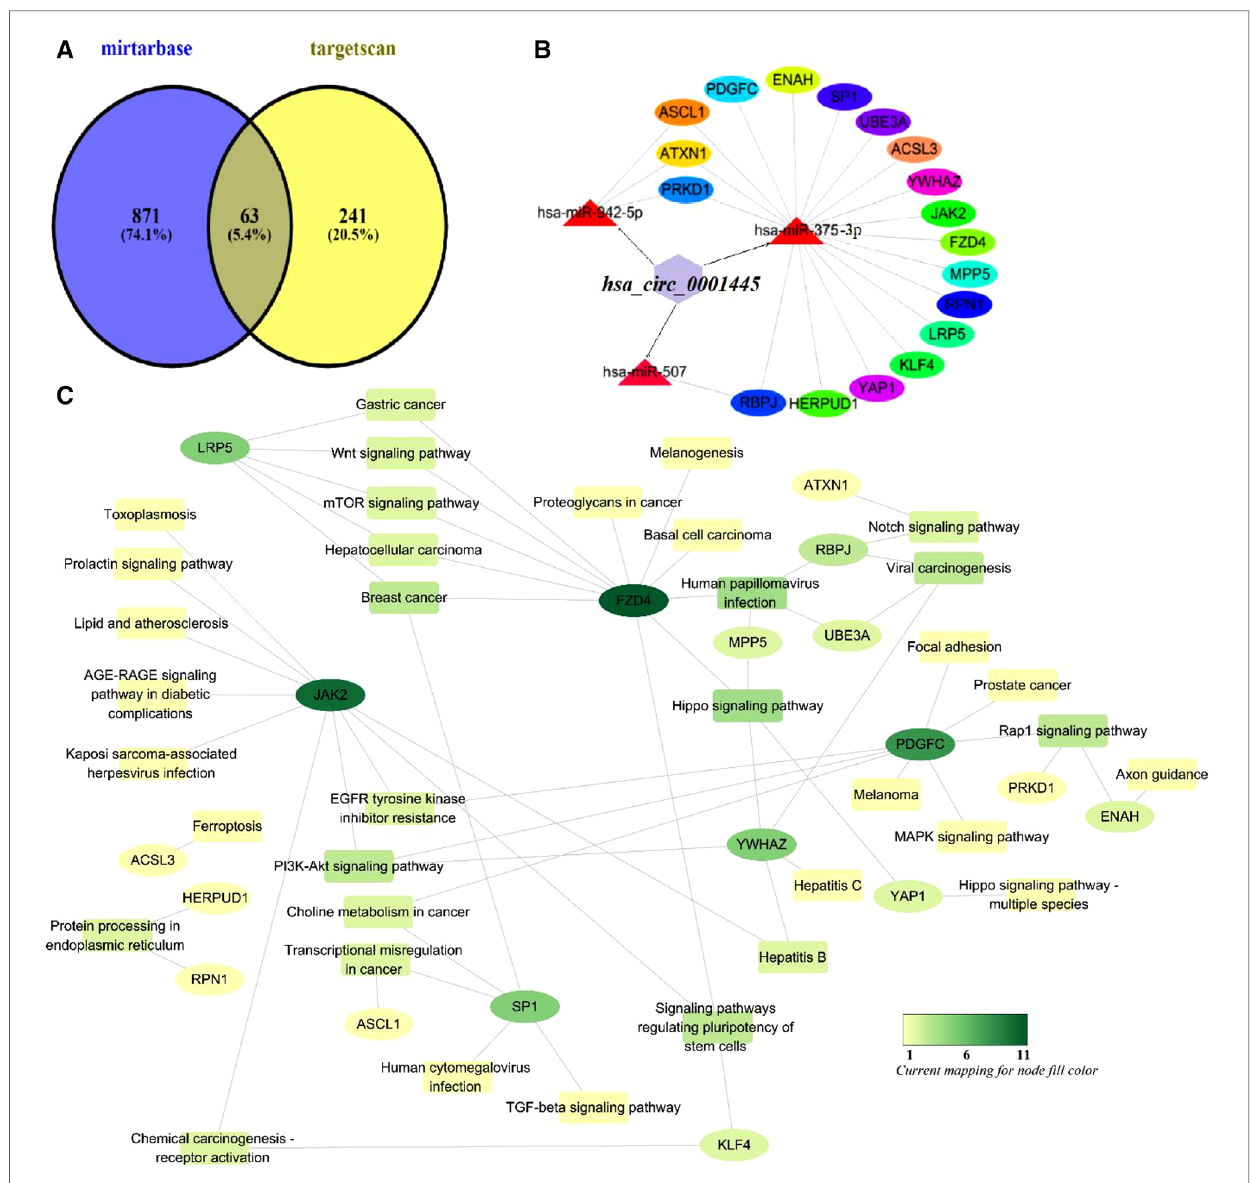
FIGURE 7 Mechanism of action of hsa_circ_0001445. ( A ) Venn diagram of genes predicted by mirtarbase and targetscan. ( B ) The subnetwork of the interactions between miRNAs and these genes. ( C ) Functional analysis of potential genes of the KEGG pathway using Cytoscape ver.